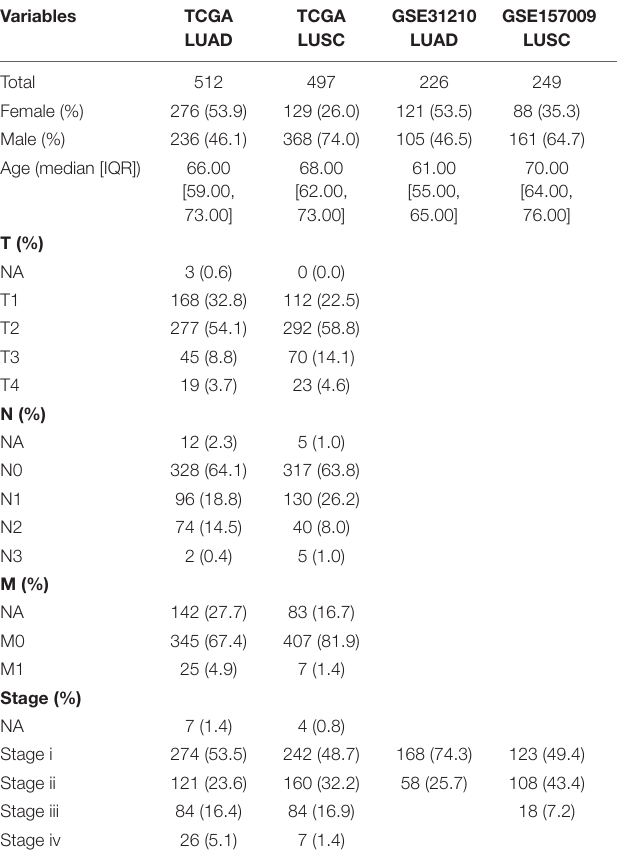
TABLE 1 | The clinical characteristics of lung cancer patients in our